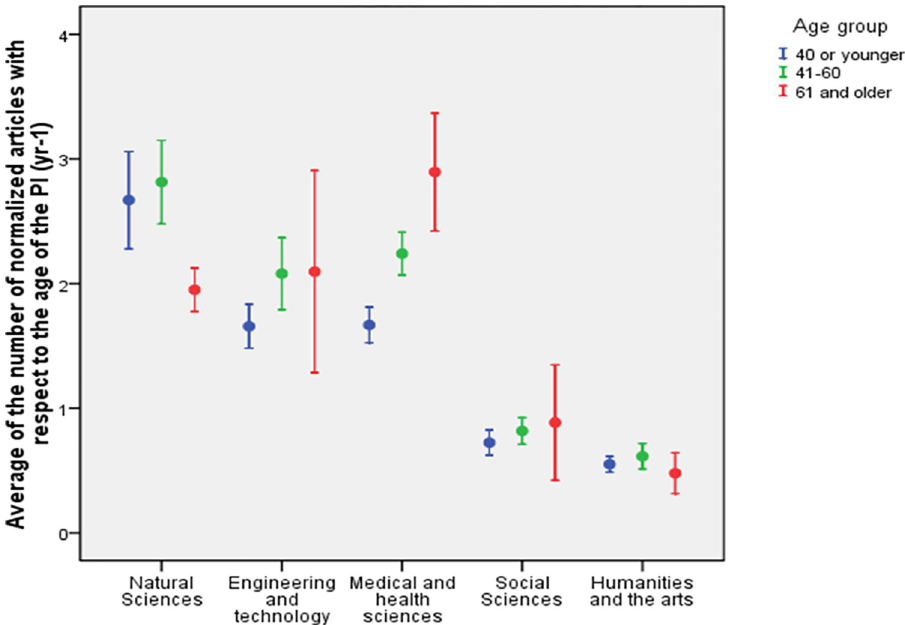
Fig 10. The average ( ± SE) number or peer-reviewed articles normalized with respect to the age of the PI (Eq. 1) across age groups and Frascati fields through all grants awarded by the Estonian Research Council between 2013– 2022. Agricultural and veterinary sciences are not shown because of low number of grant holders in the oldest age group (5 PIs).